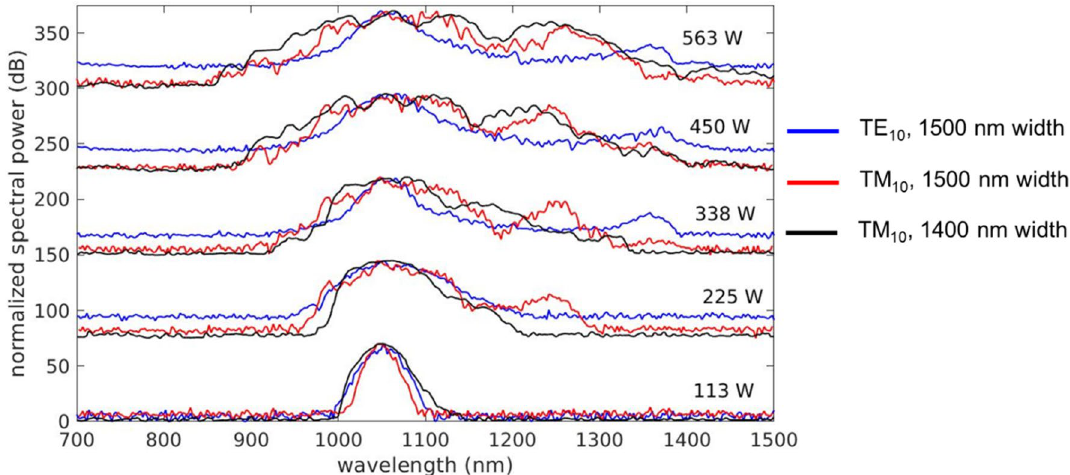
Figure 4. Output spectra of the Ta 2 O 5 waveguide for the TE 10 mode (in blue) and TM 10 mode (in red and in black) with various peak powers coupled to the waveguide. These peak powers estimated by TM 10 modes are 113 W, 225 W, 338 W, 450 W and 563 W, respectively. The spectra for TE 10 mode is measured in the waveguide of 1500 nm width (in blue) and the spectra for TM 10 mode is measured in waveguides of 1500 nm (in red) and 1400 nm (in black)